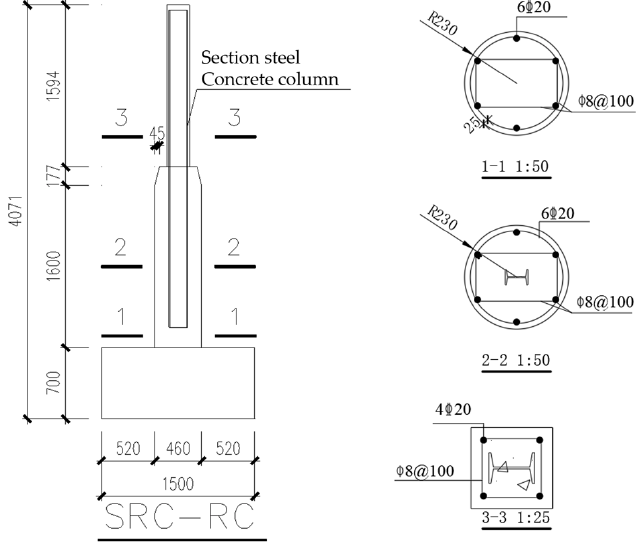
Figure 8. Dimensions and reinforcement of USSRC-LCRC1 specimens. Table 3. Parameters of the USSRC-LCRC1 specimen.